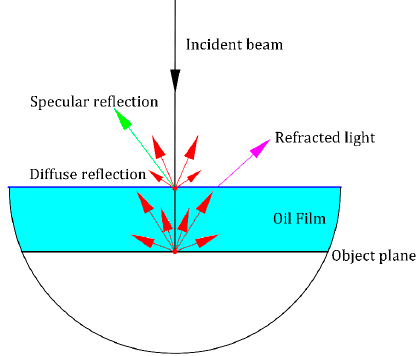
Figure 2. Local magnification of the change for incident light intensity.